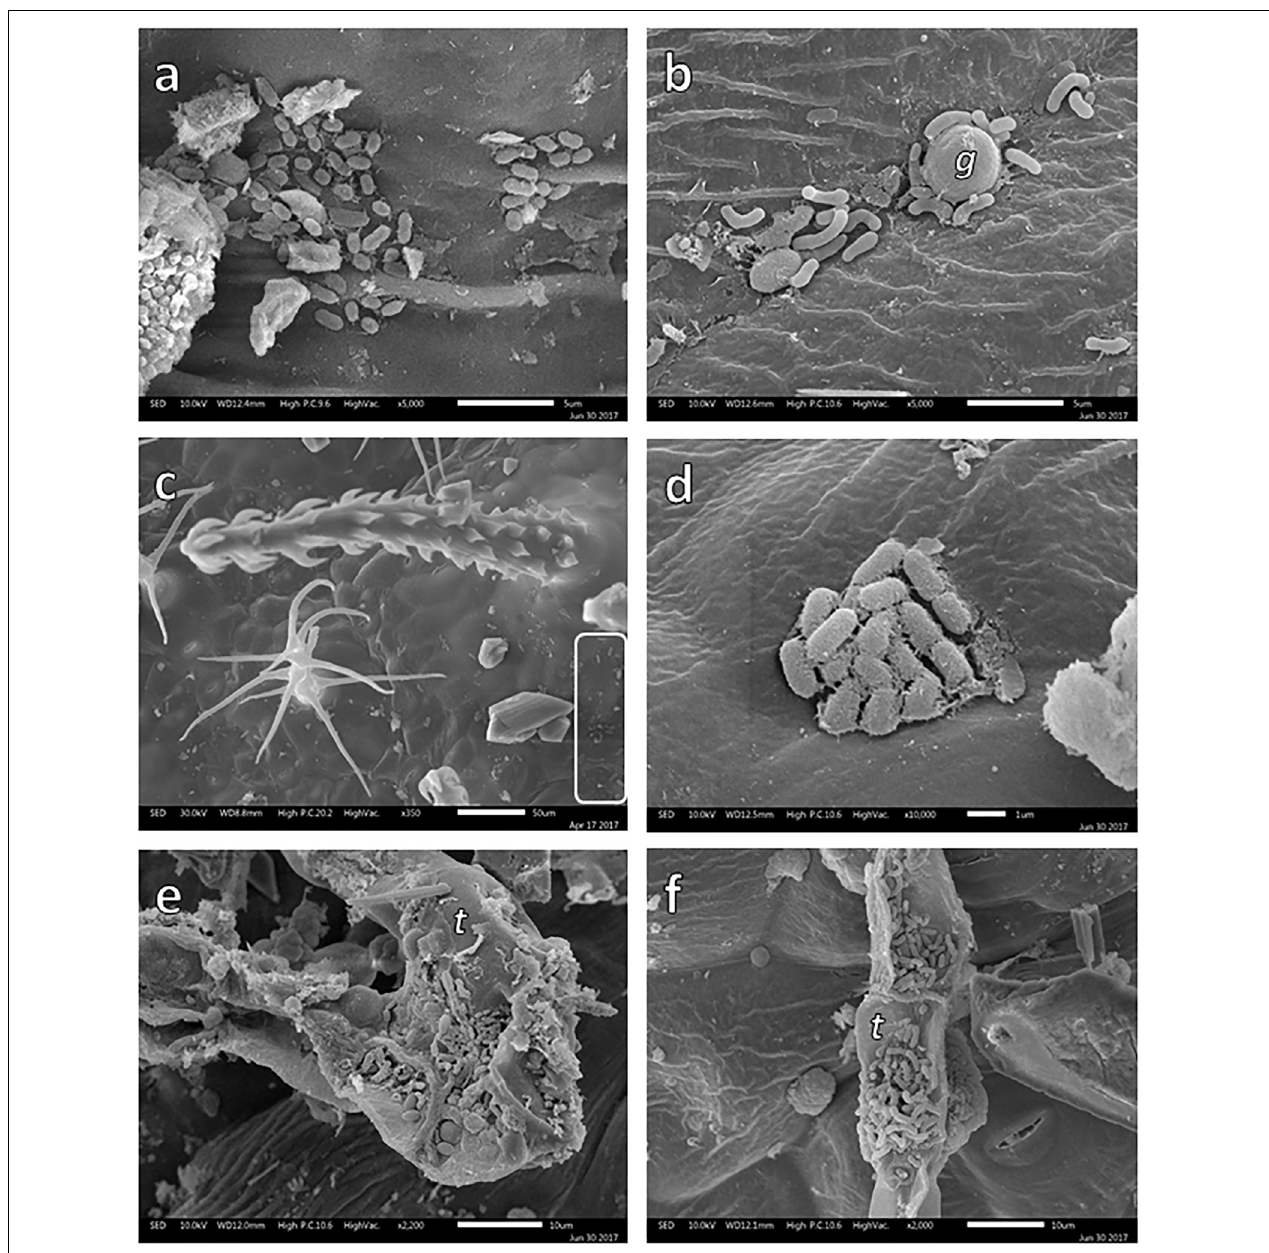
FIGURE 4 | SEM images of bacterial colonies growing on the leaf surface of Brickellia veronicifolia (a,b) , Gnaphalium sp. (c,d) , and Flaveria trinervia (e,f) colonizing mine residues. Glands = g and trichomes = t